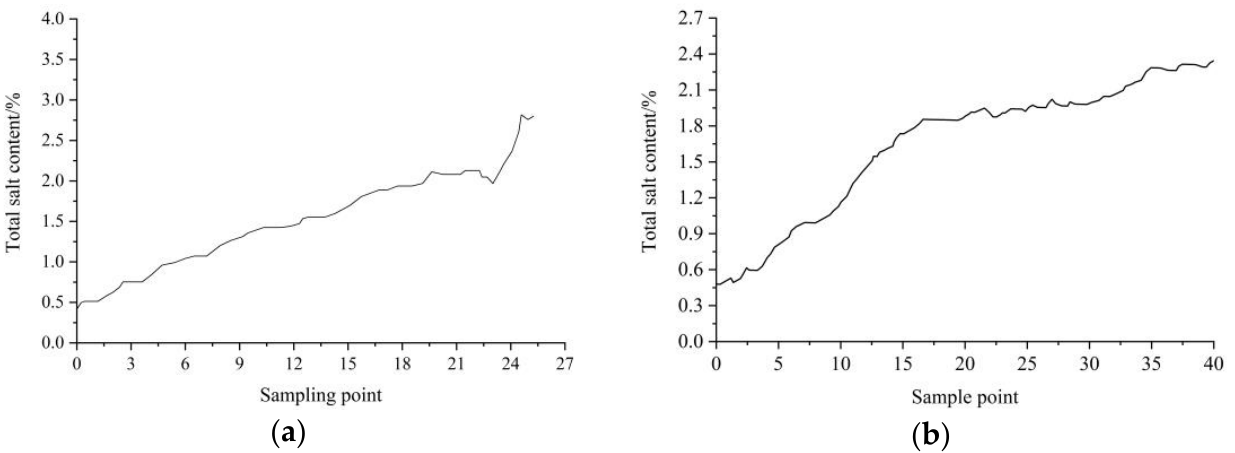
Figure 9. Distribution profile of soil salinity in the layers between 0 m and 0.2 m of two rivers: profile of soil salinity in the layers between 0 m and 0.2 m along the Yindaya River ( a ); profile of soil salinity in the layers between 0 m and 0.2 m along the Weigan River ( b ).